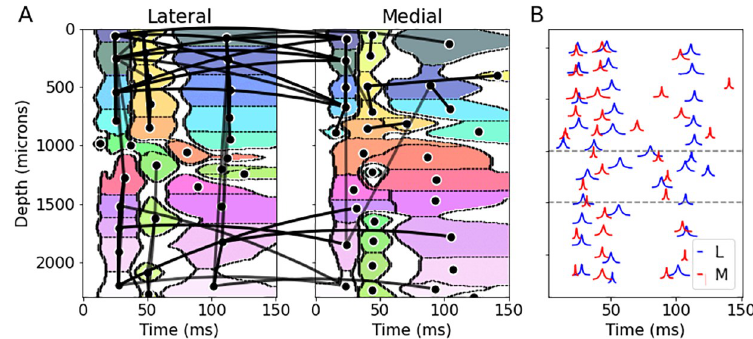
Fig 5. Per-trial shifts and correlations in CSD evoked response components. (A) Spatiotemporal plot of evoked response components for the lateral probe (left) and the medial probe (right), colored to show separate components. Black circles represent centers of mass of each component, and an edge between two black circles indicates significant correlation in the per-trial shifts of the two components (darker, thicker edges indicate larger correlation values). Within each probe, the pattern of connections suggests that many components of the early evoked response (occurring before 60 ms) have related time shifts on a trial-to-trial basis; the lateral probe also has correlated time shifts in the later evoked components. Between probes, there are connections between early evoked components at similar depths, with some evidence of shift correlations between lateral probe early components and medial probe later components. (B) Kernel density estimates of the peak times, across trials, of the evoked components in each probe with dashed lines marking putative cortical depth boundaries (separating superficial, medium, and deep layers). The medial probe responses generally precede the lateral probe responses across depths (confirmed by pairwise testing on the difference in means, p < 0.001 corrected). In addition, the ordering of responses across depths appears similar in each probe, with the earliest responses occurring in the superficial and deep layers, followed by the medium depth